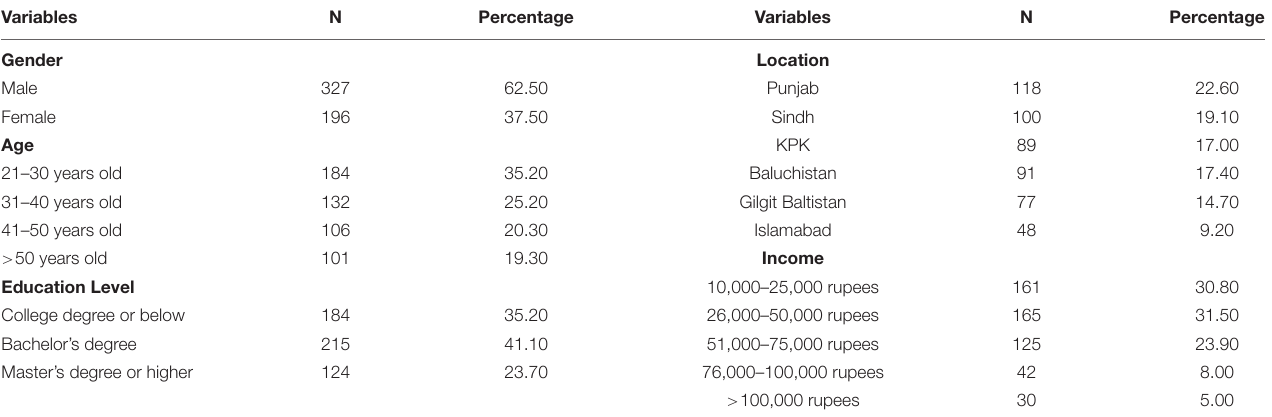
TABLE 1 | Demographic information of the